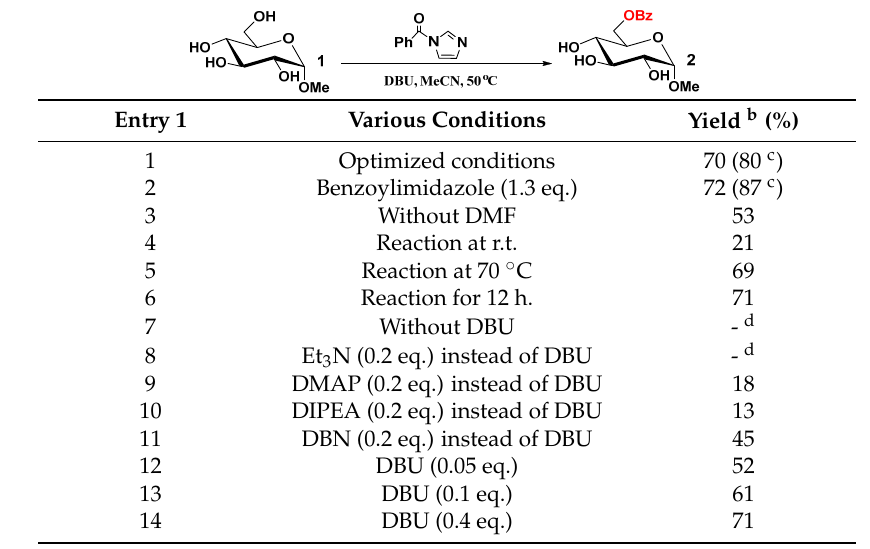
Table 1. Optimization studies on selective benzoylation of methyl α - D -glucopyranoside ( 1 ) a .